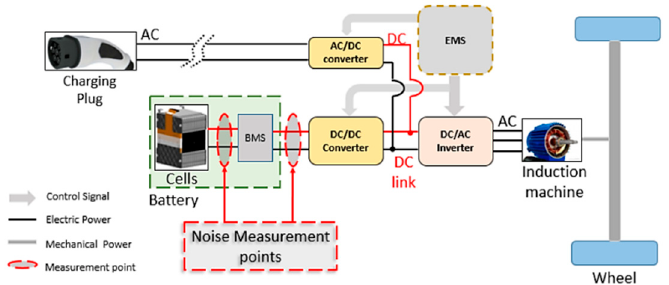
Figure 1. BEV powertrain architecture.